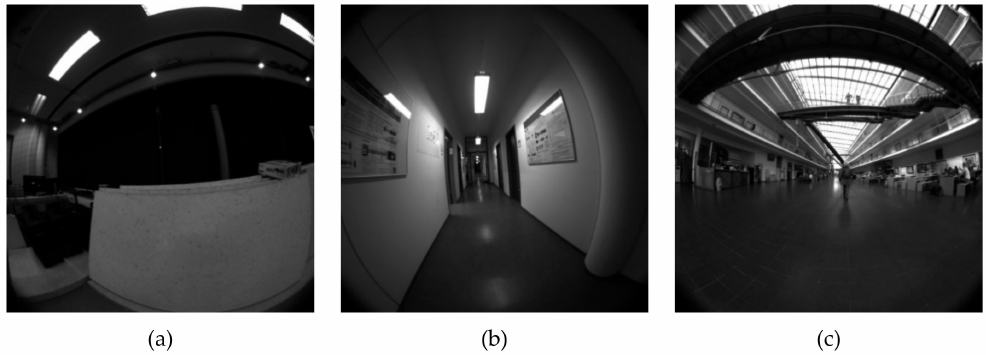
Figure 5. Sample images in the datasets: ( a ) room; ( b ) corridor; ( c )